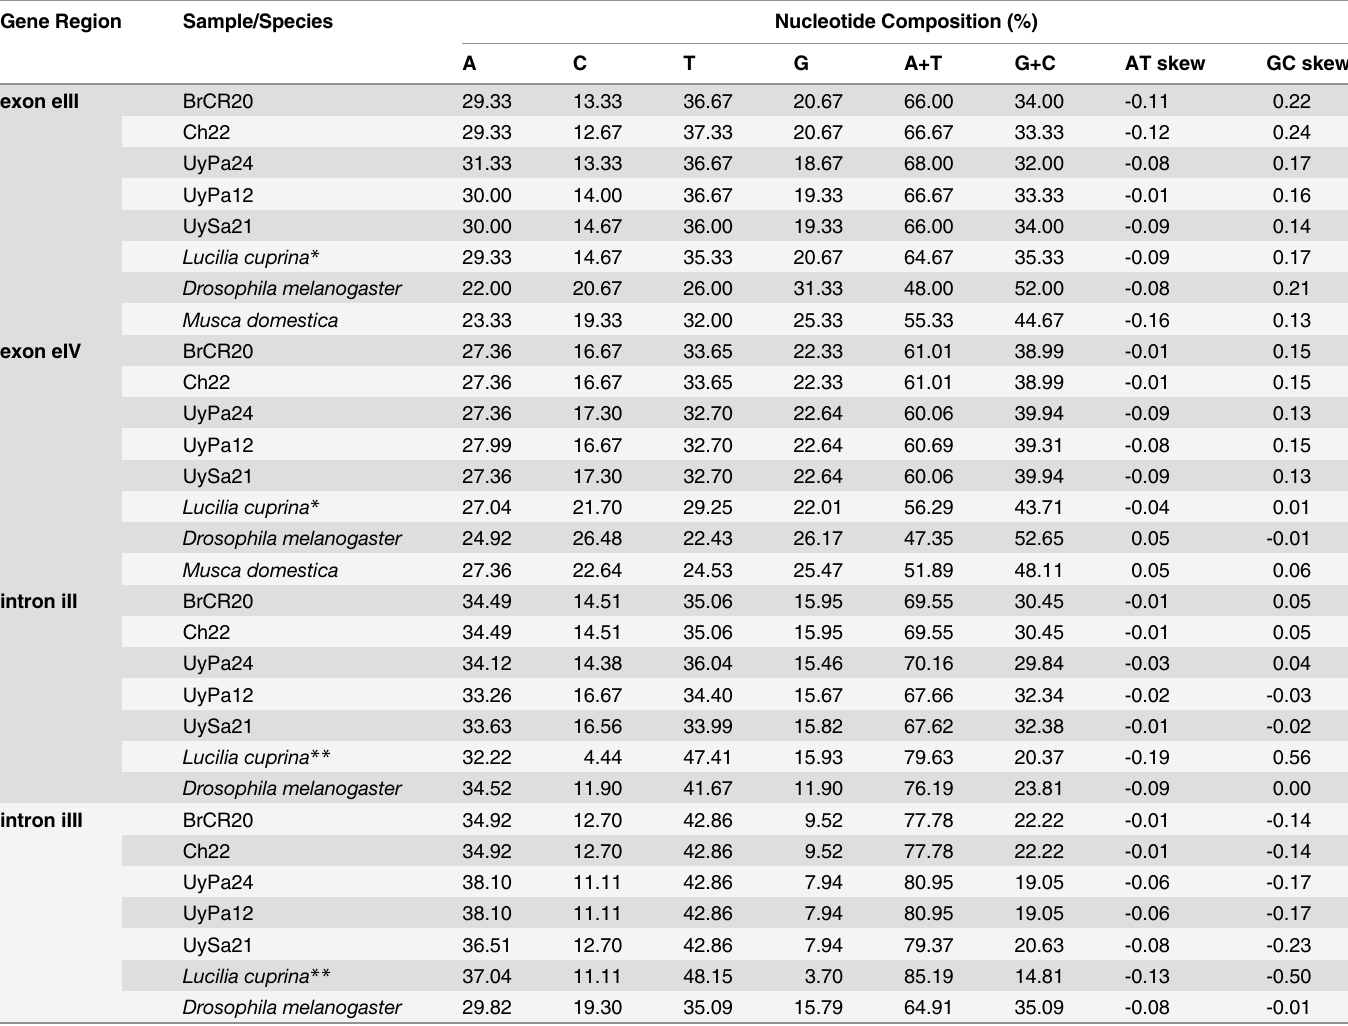
Table 2. Nucleotide composition of Ch α E7 sequences from five NWS fly individuals and three Muscomorpha species. Gene Region